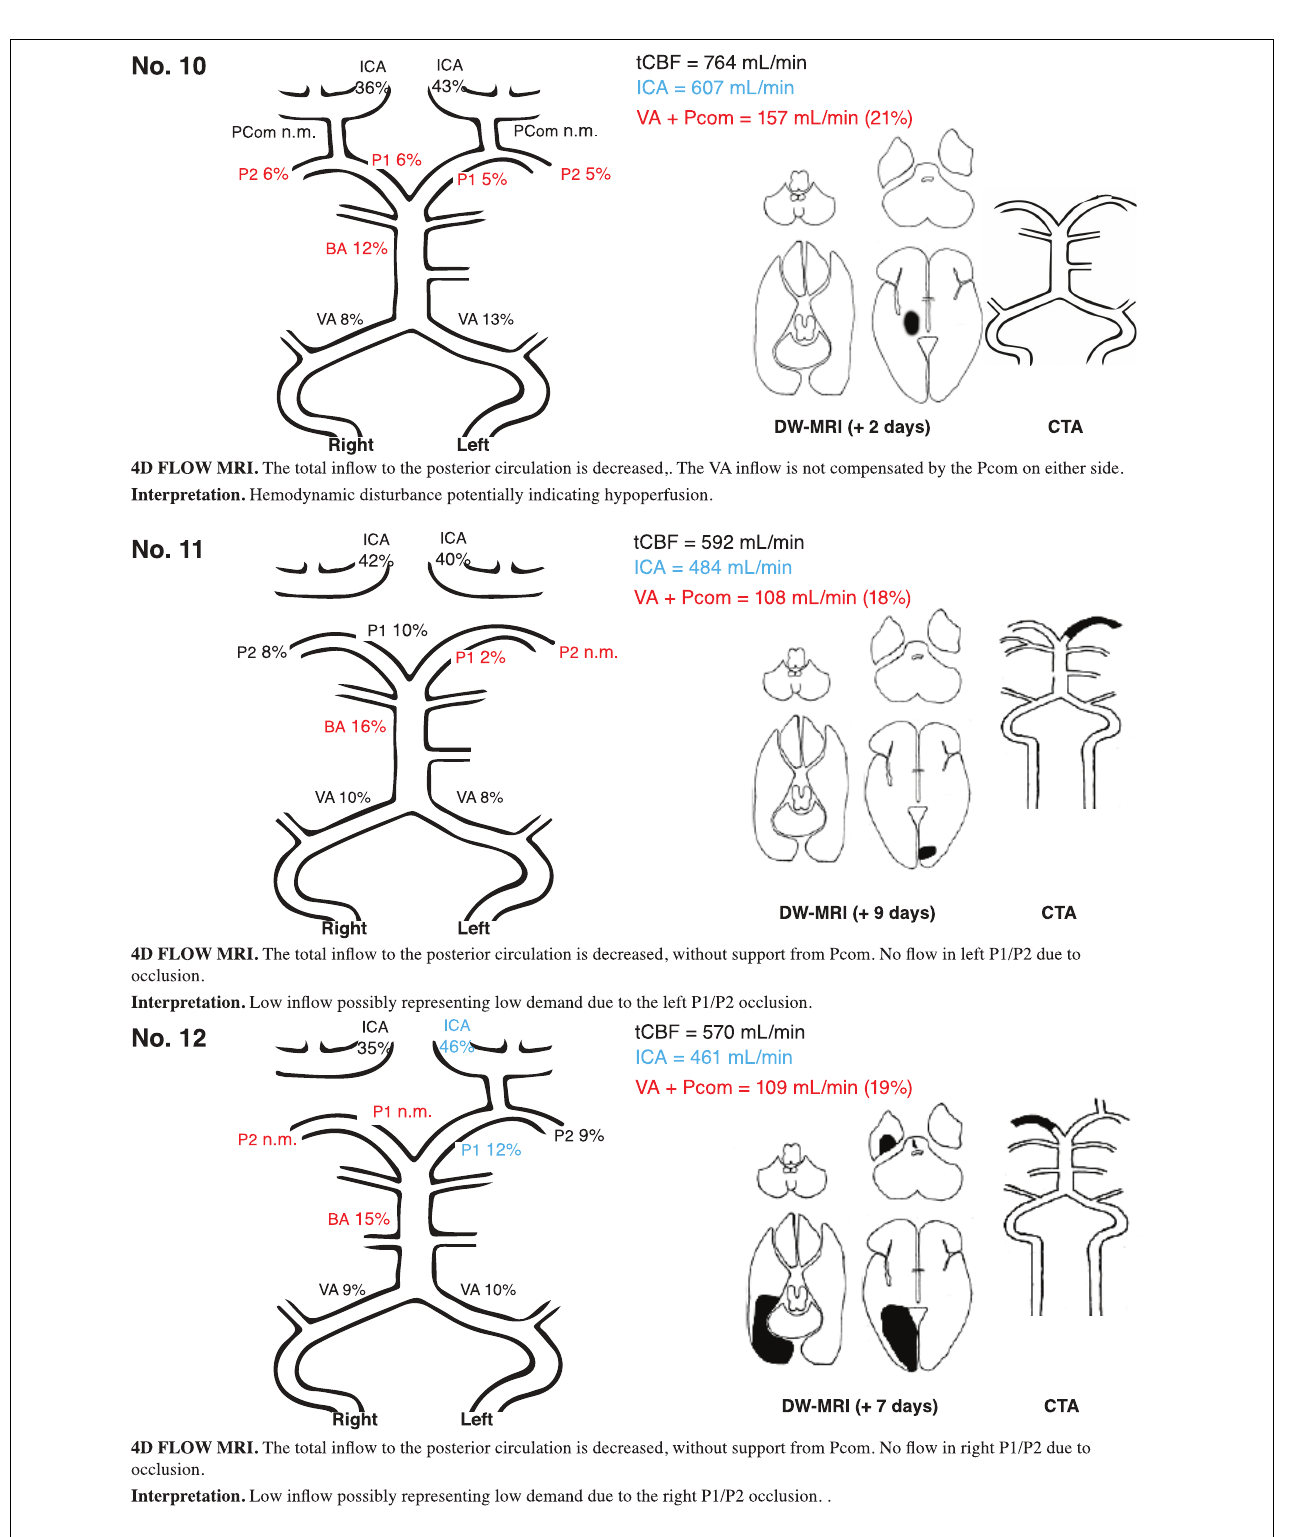
FIGURE 4 | Findings on DW-MRI, CTA, and 4D flow MRI in nine selected patients (patients no. 4-12). DW-MRI, diffusion weighted magnetic resonance imaging; CTA, computed tomography angiography; blue, high flow; red, low flow; black, flow within normal limits; VA, vertebral artery; BA, basilar artery; P1 and P2, segments of posterior cerebral artery; Pcom, posterior communicating artery; ICA, internal carotid artery; n.m., visible artery but flow not measurable.